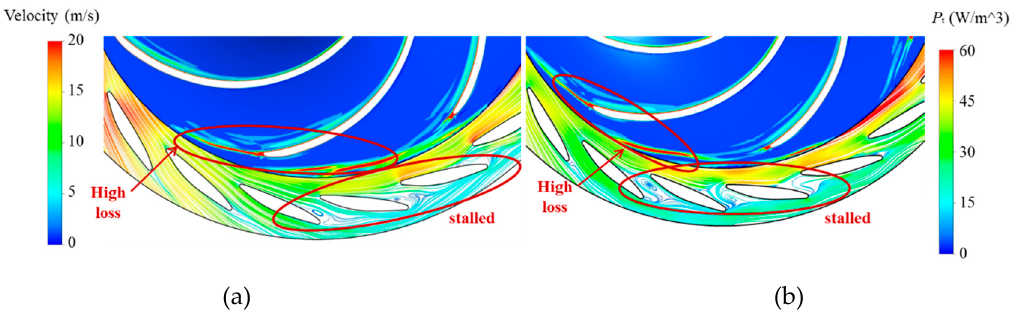
Figure 19. Instantaneous distributions of streamlines in guide vane channels and turbulent kinetic energy dissipation in the impeller at ( a ) condition IV and ( b )